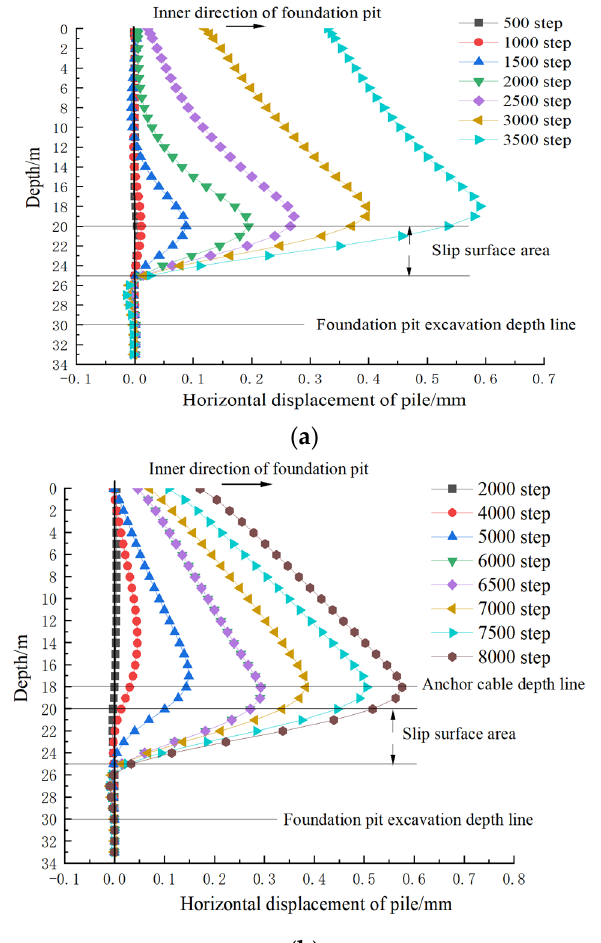
Figure 9. Displacement curve of pile body with 4.0 times pile spacing (2 piles). ( a ) The diameter of the cantilever pile is 0.8 m. ( b ) The pile diameter is 0.8 m, and the crown beam and anchor cable are set.